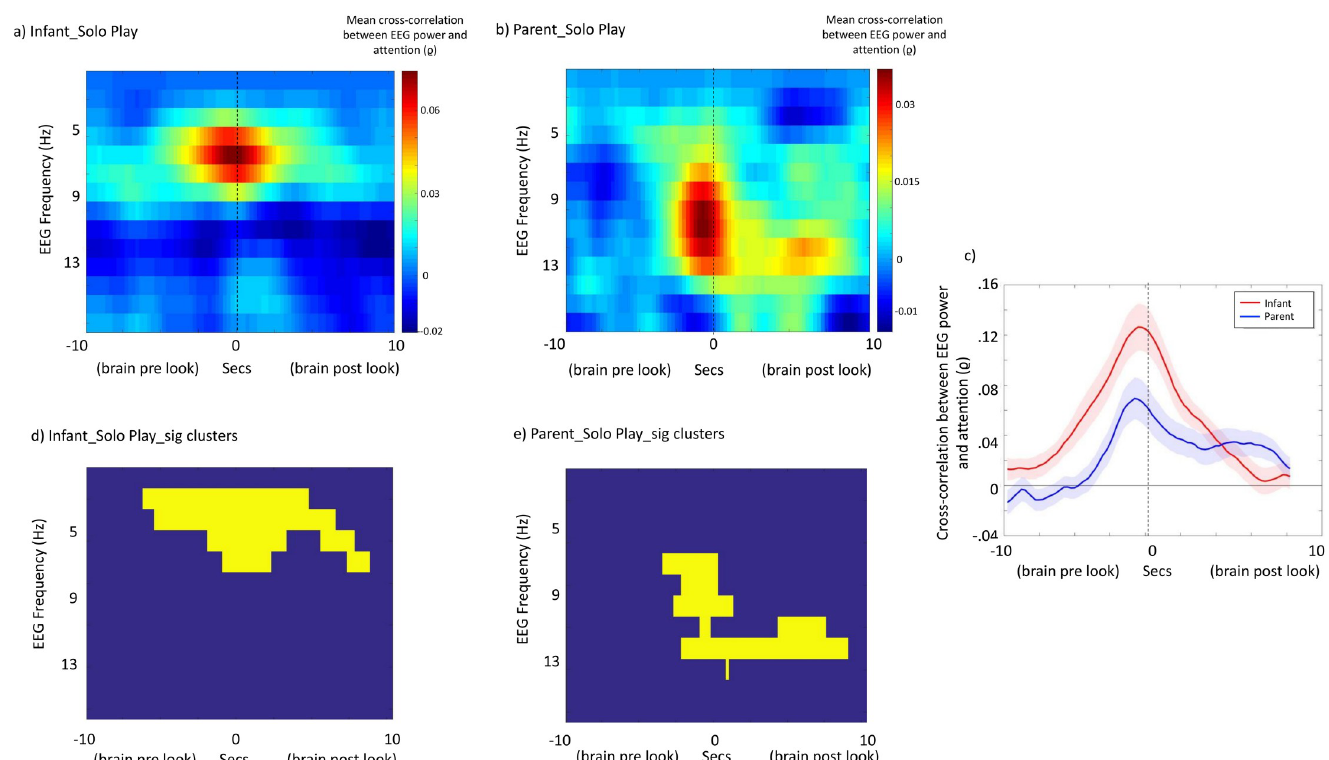
Fig 2. Brain–behaviour associations: Solo play. (a and b) Mean time-lagged cross-correlations between EEG power and visual attention for (a) infant solo play and (b) parent solo play. Time lag between EEG power and visual attention is shown on the x-axis, and the EEG frequency on the y-axis. (c) Cross-correlation plots just for those frequency bands identified from the cluster-based permutation test as showing the most marked differences from chance (infant: 3 Hz–7 Hz; adult: 6 Hz–12 Hz). x-axis shows time; y-axis, cross-correlation between EEG power and attention. Shaded areas show the standard error of the means. (d and e) Results of the cluster-based permutation statistic. Yellow squares indicate time × frequency points of significant cross-correlations. The underlying data for this figure can be found in S1 Text and S1 Data.